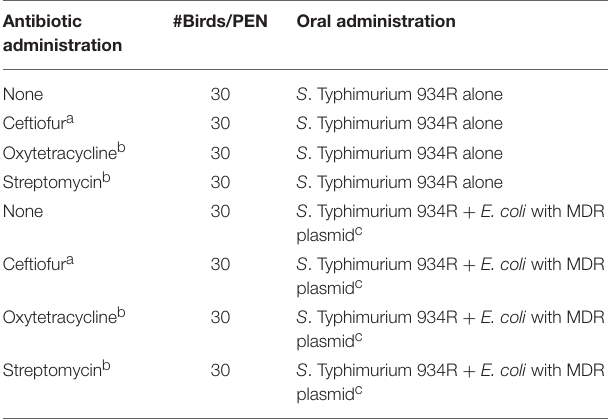
TABLE 1 | Animal Study 1: Does antibiotic administration enhance acquisition of the Newport multidrug-resistance plasmid by Typhimurium 934R in chickens?. Antibiotic